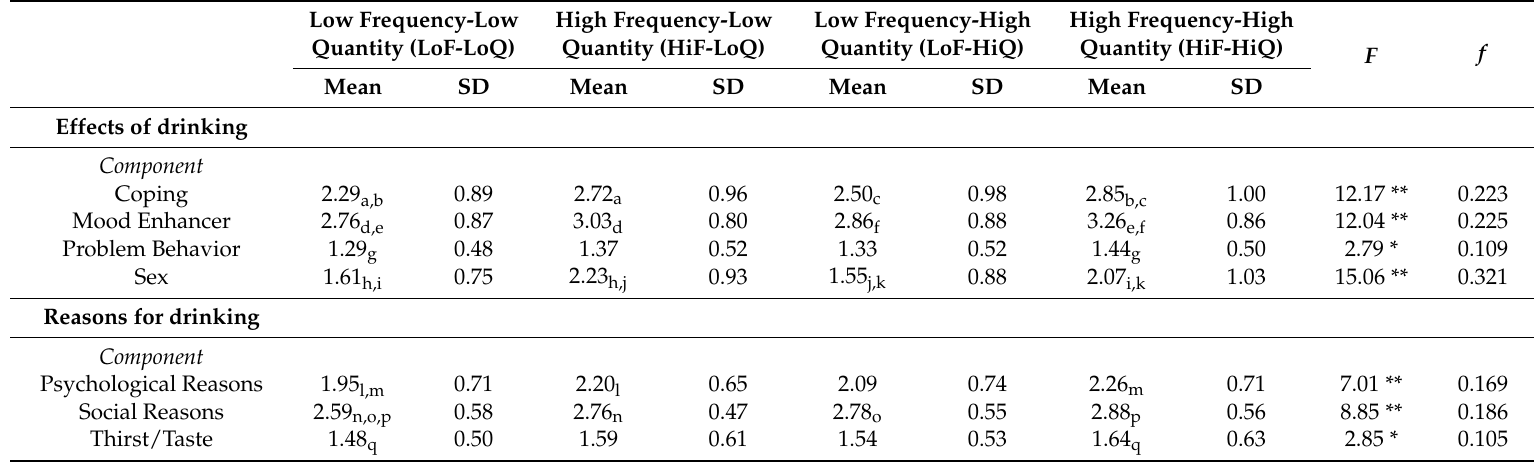
Table 6. Effects of drinking and Reasons for drinking by drinking level groups.